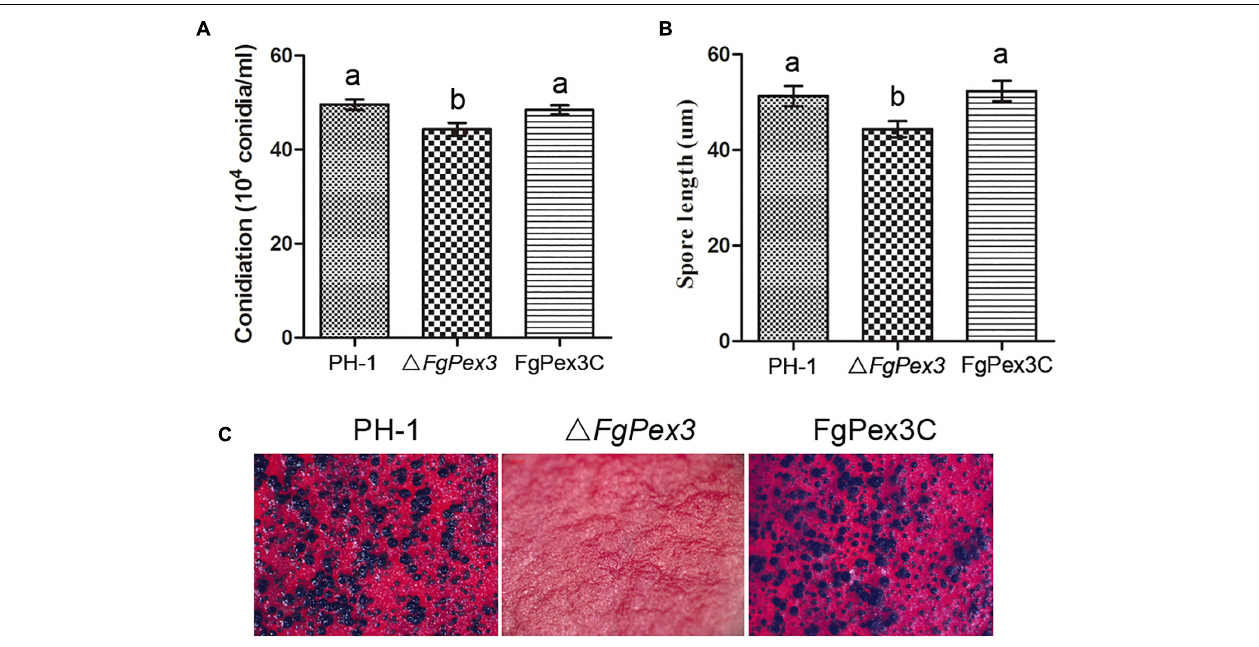
FIGURE 5 | Conidiation and sexual reproduction of PH-1, (cid:49) FgPex3 and FgPex3C. (A) Number of conidia produced in MBL medium during 6 days at 25 ◦ C. Means and standard errors were calculated from three independent replicates. Error bars represent standard deviation. Values on the bars followed by the same letter indicate no significant difference at P = 0.05. (B) Size of conidia produced by PH-1, (cid:49) FgPex3 and FgPex3C strains. Error bars indicate the standard deviations of three repeated experiments. Values on the bars followed by the same letter are not significantly different at P = 0.05. (C) Perithecia formation of PH-1, (cid:49) FgPex3 and FgPex3C on carrot agar plates were photographed at 2 weeks post-fertilization. Mutant (cid:49) FgPex3 failed to produce any perithecia.